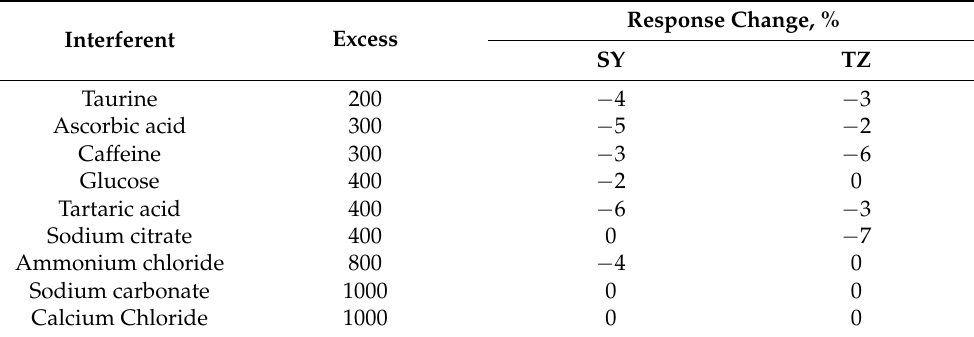
Table 3. The effect of various interferents on the simultaneous responses of SY and TZ (each 1 µ